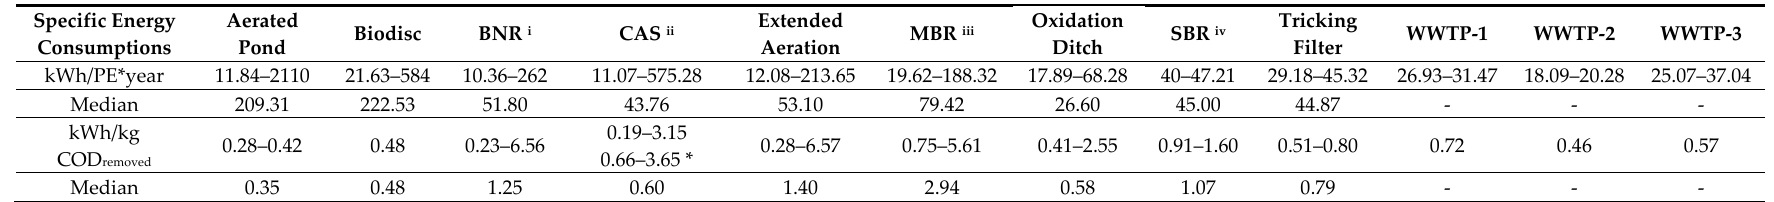
Table 3. Energy consumption respect to treatment technology [24]—Comparison with energy consumption of the studied